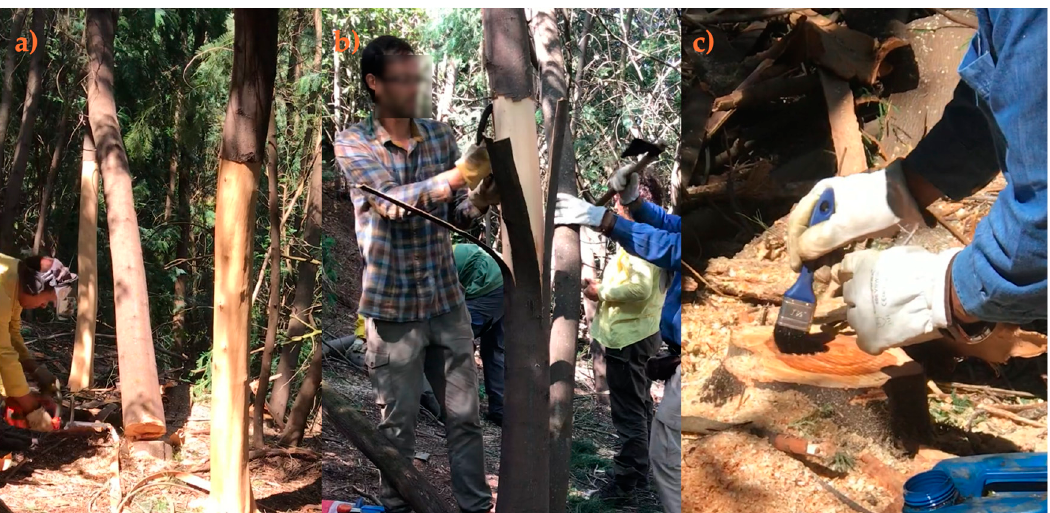
Figure 8. Cutting work and application of control techniques for invasive species. ( a ) Cutting; ( b ) peeling the acacias; and ( c ) application of glyphosate.